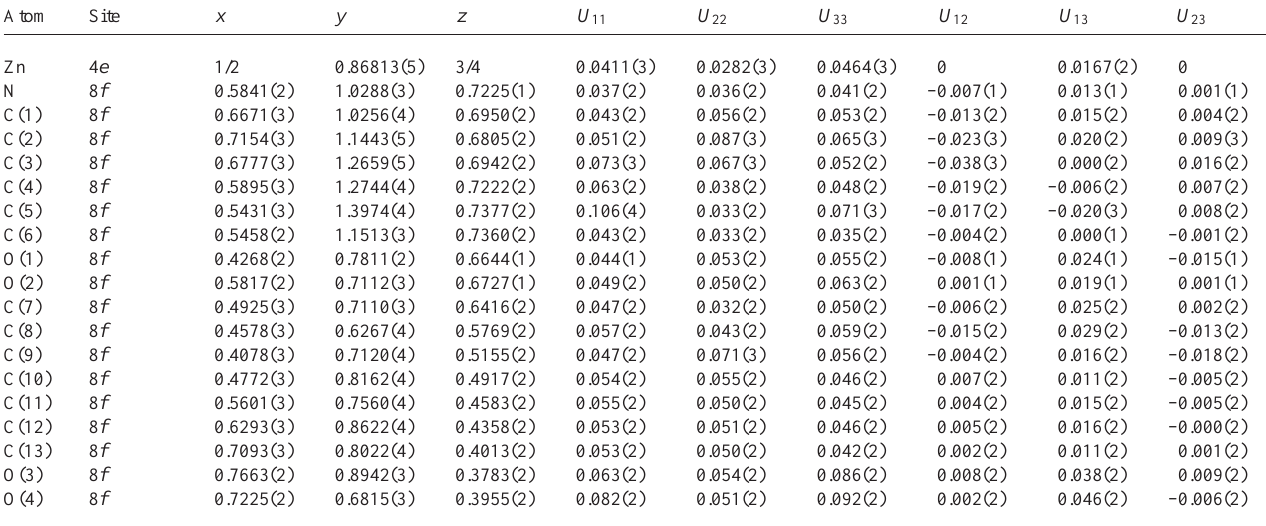
Table 3. Atomic coordinates and displacement parameters (in Å 2 )